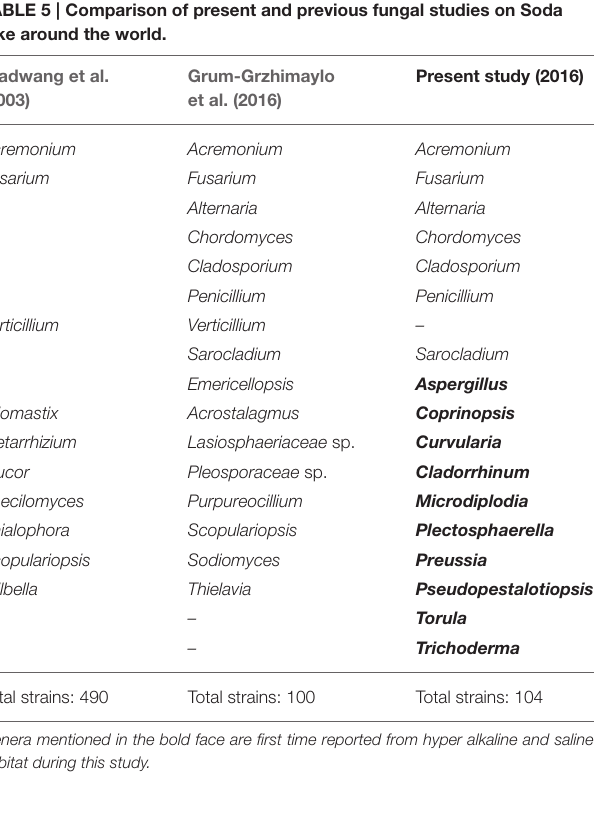
Frontiers in Microbiology |